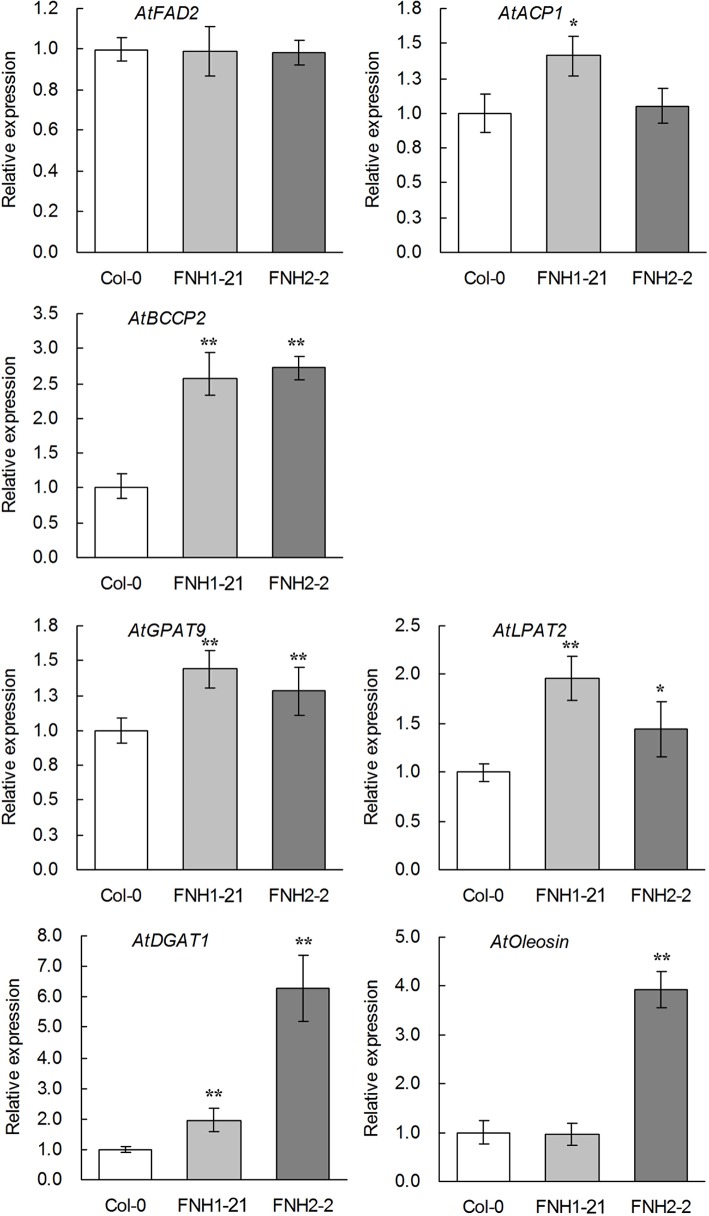
Altered Expression of Genes Involved in the FAs and TAG Biosynthesis Pathway.Values are means ± SE (n = 3). Total RNA was prepared from developing siliques of transgenic lines. Gene expression levels are shown relative to the expression of AtActin7 in each sample. The transcription level of each gene in the wildtype was set as 1.0.Asterisks indicate significant differences between the wild-type and transgenic lines at p < 0.01 (**) and p < 0.05 (*).